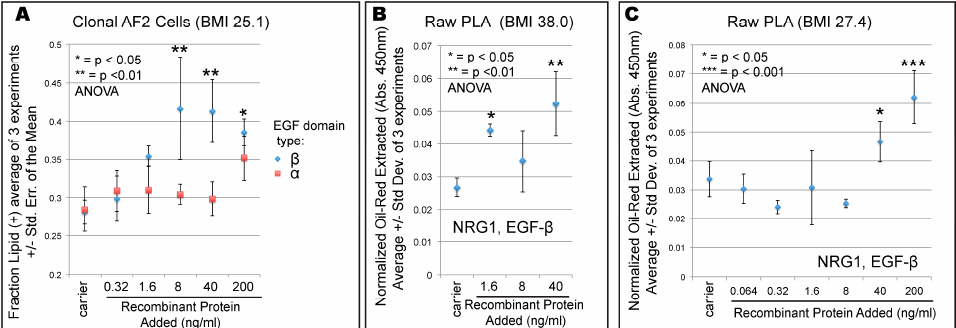
Figure 4. Recombinant NRG1 can re-program stem cells to greater differentiation. ( A ) Recombinant NRG1 encompassing either an EGF- α or EGF- β domain was added to the culture media for AF2 clonal cells and adipose differentiation was measured. Shown is the average and standard error of the mean for 3 independent experiments, each with 3 replicates. ( B ) Validation with recombinant NRG1 EGF- β in raw PLA (donor BMI = 38.0). Plotted is the average, with error bars representing +/- one standard deviation of 3 biological replicates. The asterisks represent p -values of 1-way ANOVA relative to the carrier control. ( C ) Validation of recombinant NRG1 EGF- β in raw PLA (donor BMI = 27.4). Plotted is the average, with error bars representing +/- one standard deviation of 3 biological replicates. The asterisks represent p -values of 1-way ANOVA relative to the carrier control.